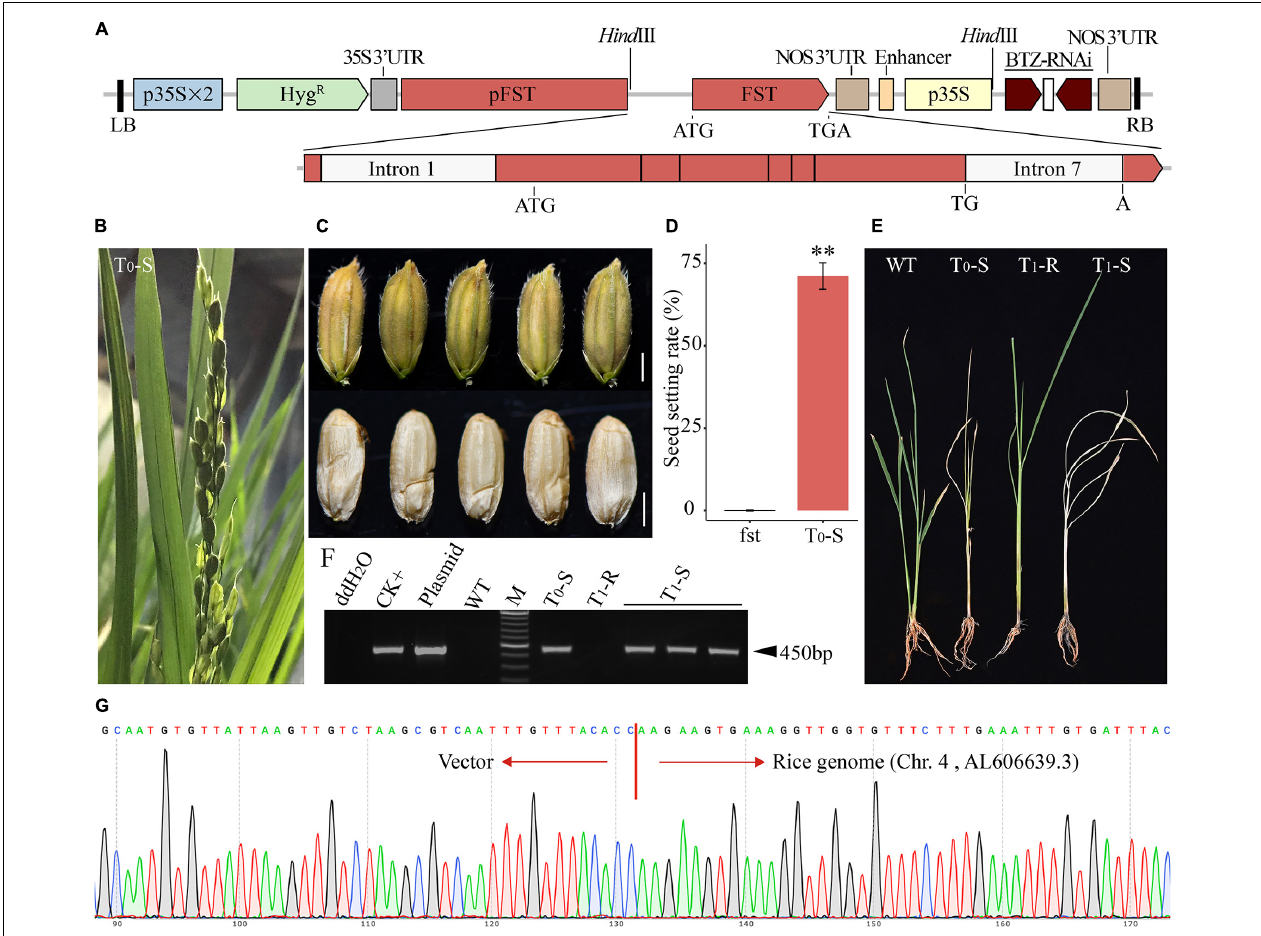
FIGURE 3 | The phenotype of the genetically engineered FS line. (A) Diagram of the expression vector AT73. p35S, cauliflower mosaic virus 35S promoter; p35S × 2, double 35S promoter; Hyg R , hygromycin resistance gene; 35S 3 (cid:48) -UTR, the 3 (cid:48) -UTR of the 35S promoter; BTZ-RNAi, the inverted repeat sequence of the 304 bp fragment of CYP81A6 ; LB and RB, left and right borders of the T-DNA, respectively; NOS 3 (cid:48) -UTR, the 3 (cid:48) -UTR of Nos; pFST, the promoter of the FST gene. (B) A mature panicle of a transgenic complemented T 0 BTZ S plant. (C) The mature seeds of a transgenic complemented T 0 BTZ S plant (scale bar, 2 mm). (D) Characterization of SSR in an FS plant and BTZ S T 0 line (T 0 -S). The data are presented as means ± SDs ( n = 10), and a statistical analysis using t -tests indicated the significant differences ( ∗∗ p < 0.01). (E) Symptoms of a wild-type (WT) Ilmibyeo sub-plant and transgenic T 0 and T 1 sub-plants 7 days after a BTZ foliar spray. T 0 -S: T 0 BTZ S plant; T 1 -R: T 1 BTZ R plant; T 1 -S: T 1 BTZ S plant. (F) Agarose gel electrophoresis results of PCR screening using Hyg R -specific primers. CK + : transgenic positive plant; Plasmid: HPE203 plasmid DNA with Hyg R ; M: Thermo Scientific GeneRuler DNA Ladder Mix (SM0333). (G) Representative chromatograms of the transgene integration locus in T 0 transgenic event AT73-28. SSR, seed setting